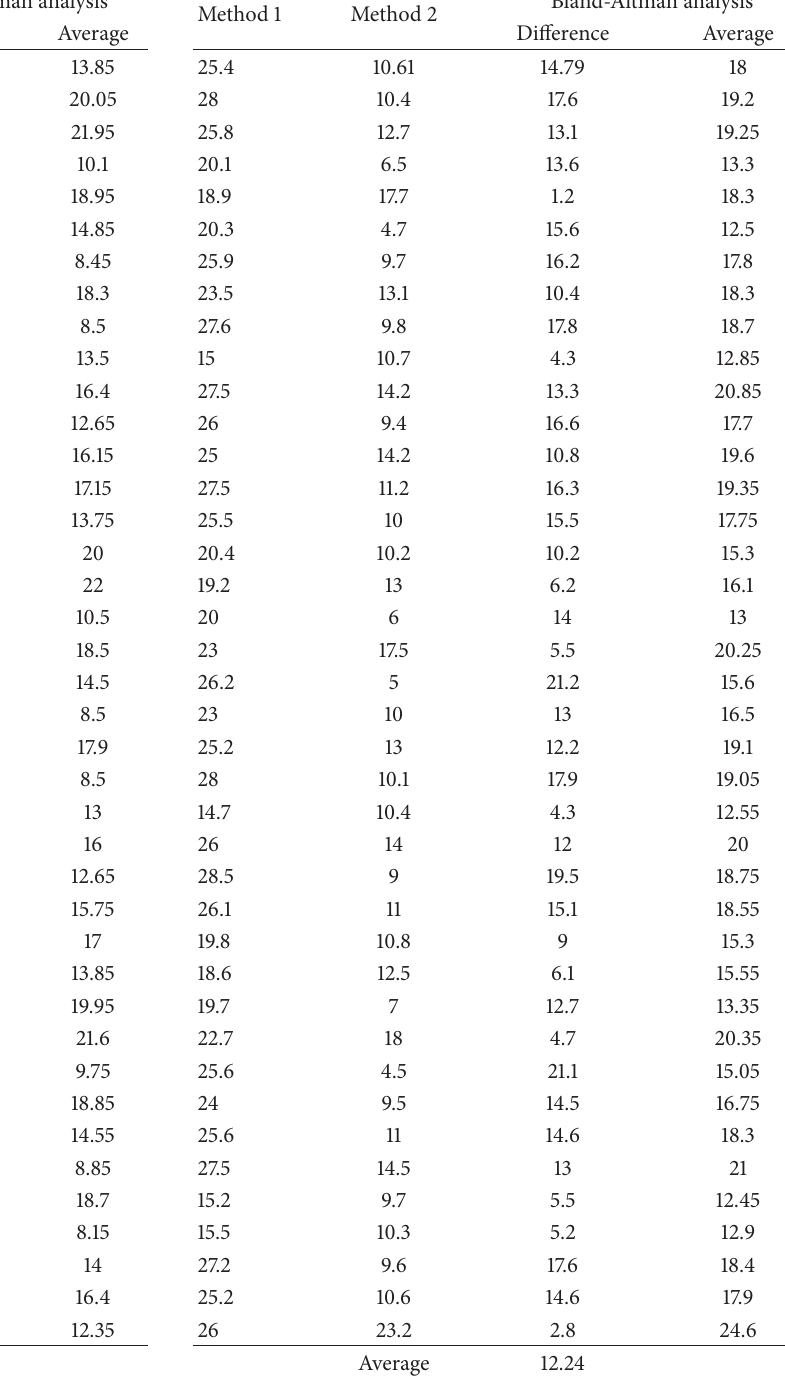
Table 4: Quarter I-T/S-N Bland-Altman analysis (see Figure